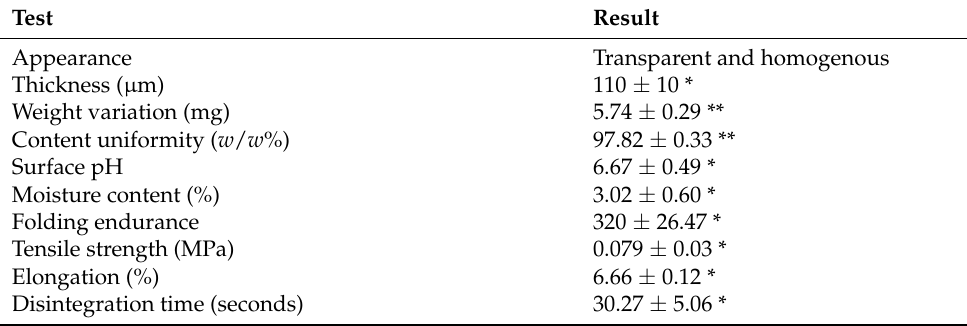
Table 6. Physical and mechanical features of tadalafil-loaded niosomal oral